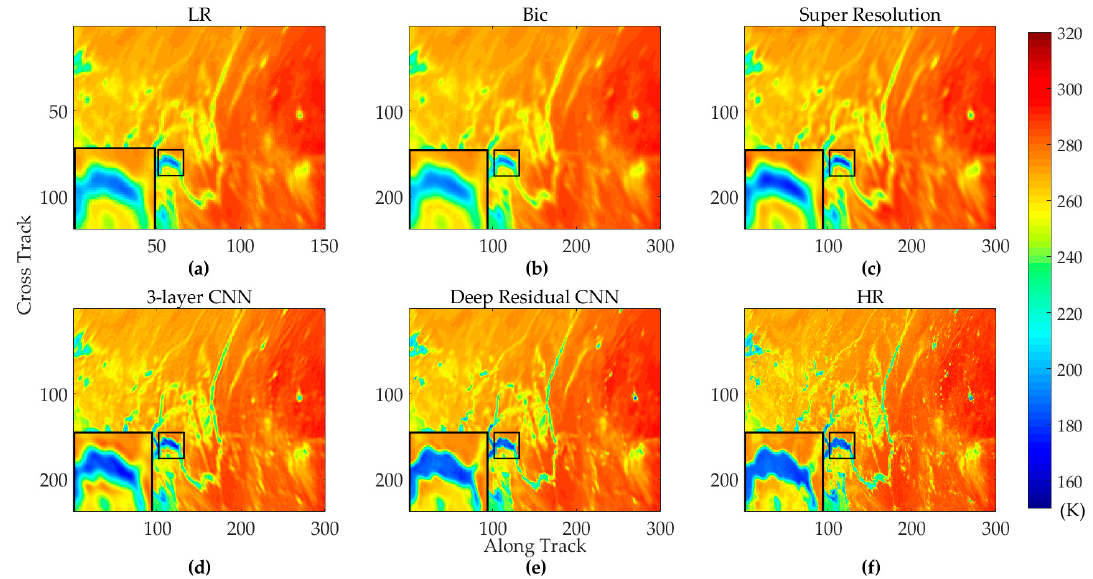
Figure 9. Experiment results of the scene 10 (outside training/testing set). ( a ) The simulated antenna temperature image I LR ; ( b ) The bicubic interpolation result; ( c ) The super resolution result; ( d ) The 3-layer CNN result; ( e ) The deep residual CNN result; ( f ) The simulated brightness temperature image I HR .